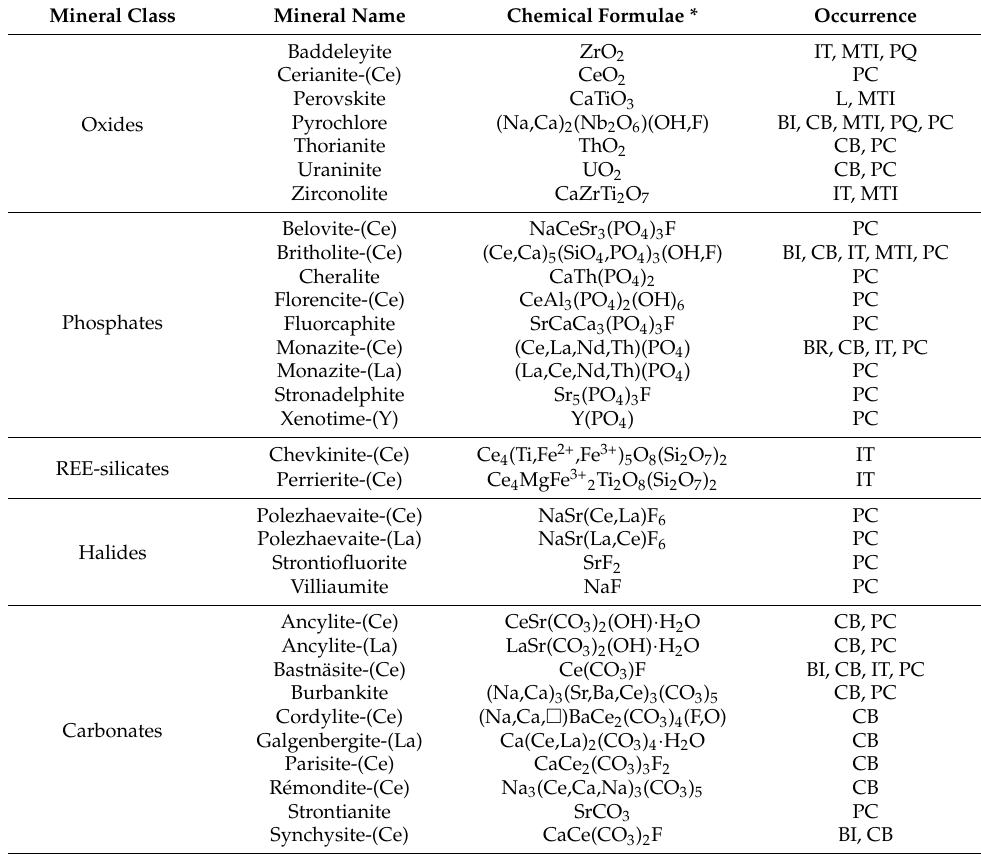
Table 8. Rare accessory minerals in agpaitic and miaskitic